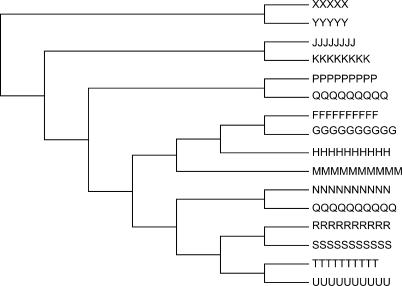
Topology of a Typical Unbalanced Tree of 16 Taxa